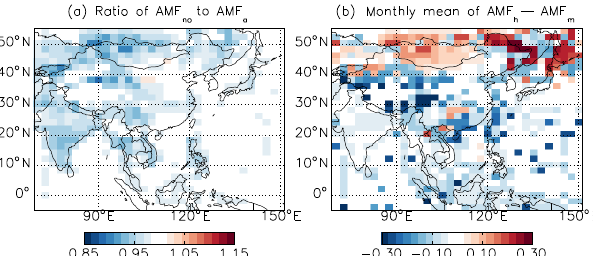
Figure 9. (a) Ratio of AMFs without aerosols (AMF no ) to AMFs with aerosols (AMF a ) . (b) Differences of the monthly mean of AMF h versus AMF m . AMF h denotes a value using AOD and SSA at each measurement time, and AMF m is a value using monthly mean AOD and SSA. Aerosol optical properties used in the calcu- lation are from OMI observations (OMAERUV) for March